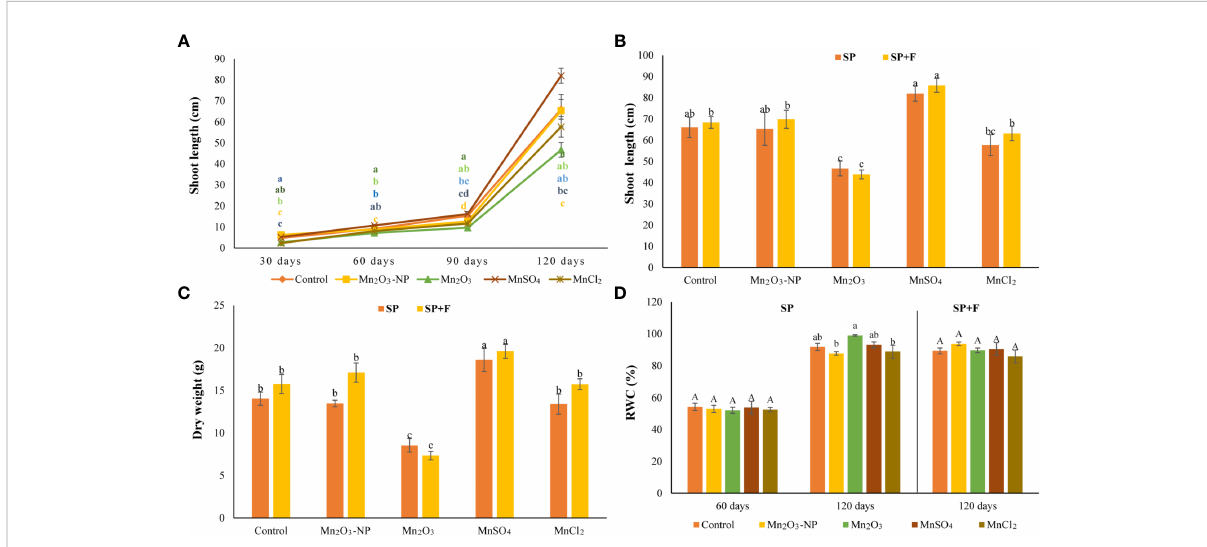
FIGURE 2 Shoot length of plants primed with different Mn forms (grown in SP condition) at different time intervals (A) ; the comparison of shoot length (B) and dry weight (C) of plants grown in SP and SP+F condition at 120 days; relative water content (D) . Data points and error bars represent mean and S.E. (n = 3). Values with different letters indicate signi fi cant differences at the P < 0.05 level between different Mn